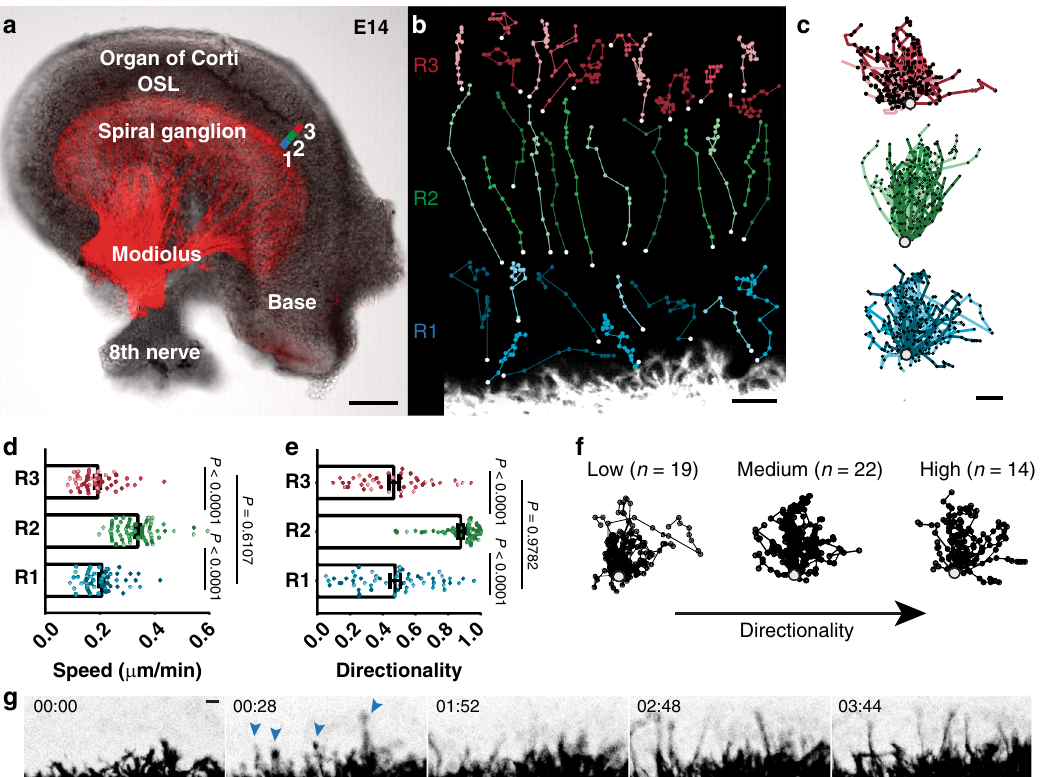
Fig. 3 SGN peripheral processes exhibit a variety of outgrowth behaviors. a A wholemount E14 cochlea, with SGNs genetically labeled red using Bhlhb5 cre and an Ai14 tdTomato reporter. Process outgrowth was imaged in three different regions of E14-E15 cochleae. Region 1 (blue, R1) is immediately adjacent to the ganglion; region 2 (green, R2) is in the developing osseous spiral lamina (OSL), and region 3 (red, R3) is close to the organ of Corti. See Supplementary Movies 2 – 4. b Representative trajectories of processes imaged as they grew through each region. c All trajectories were collapsed onto a common origin, revealing overall differences in the pattern of growth in each region. N = 3 cochleae for each region with n = 55 R1 trajectories, 64 R2 trajectories, and 44 R3 trajectories. d , e Quanti fi cation of the speed ( d ) and directionality ( e ) of SGN peripheral process outgrowth in R1, R2, and R3 (shown as raw data with mean ± SEM indicated). Growth is faster and more directed in R2 than in R1 or R3. Within R1, some SGN processes are as directed as those in R2, with directionality indices greater than 0.66. Signi fi cance was assessed using ANOVA with Tukey ’ s multiple comparison test. R1 vs R2 speed, P < 0.0001; R1 vs R2 directionality, P < 0.0001; R1 vs R3 directionality, P = 0.9782; R1 vs R3 speed, P = 0.6107; R2 vs R3 directionality, P < 0.0001; and R2 vs R3 speed, P < 0.0001. f R1 trajectories were grouped according to directionality, from low (0 – 0.33) to medium (0.33 – 0.66) to high (0.66 – 1). The number of trajectories in each group is indicated. Source data are provided as a Source data fi le. g Frames from a video (Supp. Movie 2) showing a subset of SGN peripheral processes (arrowheads) that grow ahead of the overall wavefront. Time is indicated in hh:mm. Scale bars: 100 µ m ( a ), 10 µ m ( b , c , g